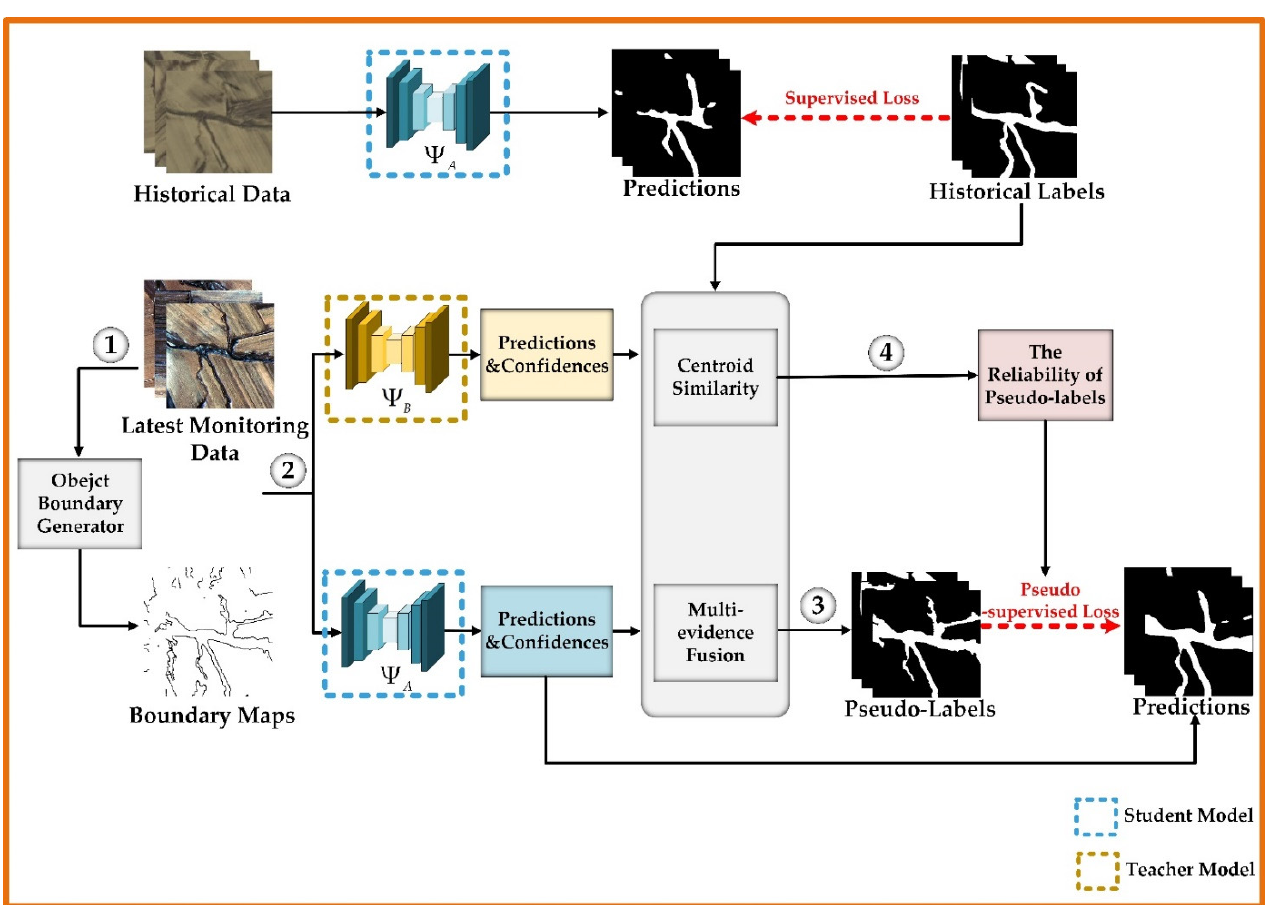
Figure 2. The training flowchart of the proposed method. In the flowchart, our method contains a student model and a teacher model, and the training of the latest monitoring data is conducted sequentially from 1 to 4.